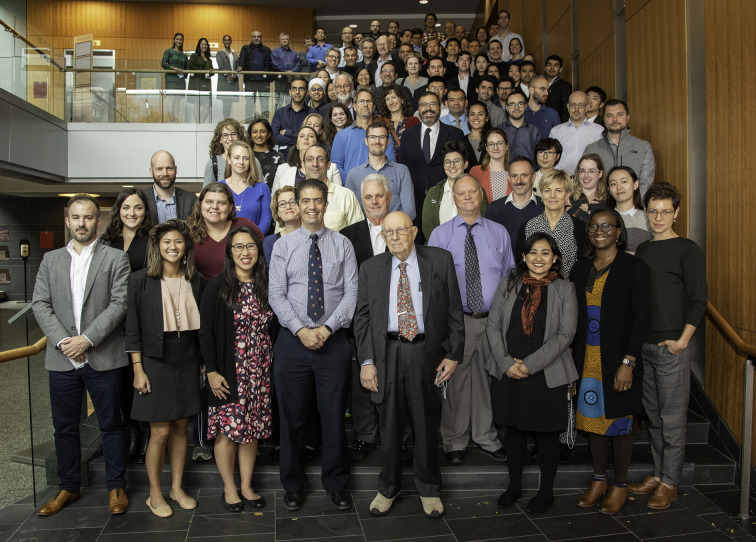
Attendees of the 2nd biennial International Precision Vaccines Conference. The 2nd biennial IPVC (17th and 18th October 2019), sponsored by the Boston Children’s Hospital Precision Vaccines Program, was held at the Joseph B. Martin Conference Center at Harvard Medical School (Boston, MA, USA).